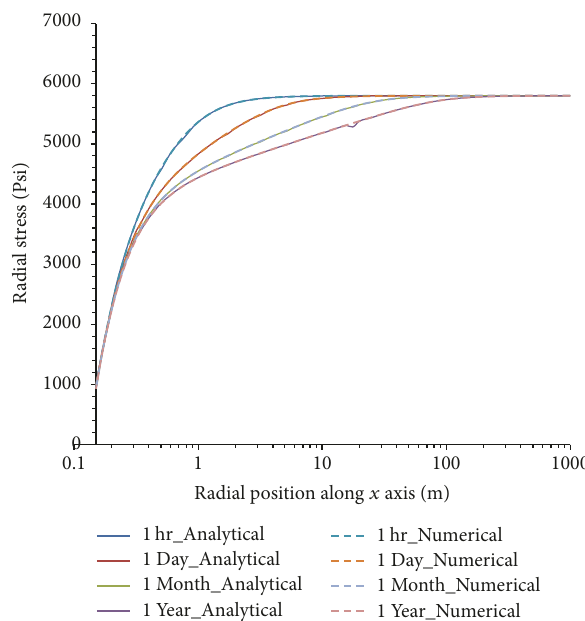
Figure 3: Pore pressure as a function of radius and time in poroelastic medium with 𝜎 𝐻 = 5800 psi and 𝜎 ℎ = 5500 psi, 𝑃 𝑟 = 5500 psi, 𝑃 𝑤 = 1000 psi, 𝑘 𝑥 = 0.01 md, and 𝑘 𝑦 = 0.01 md.